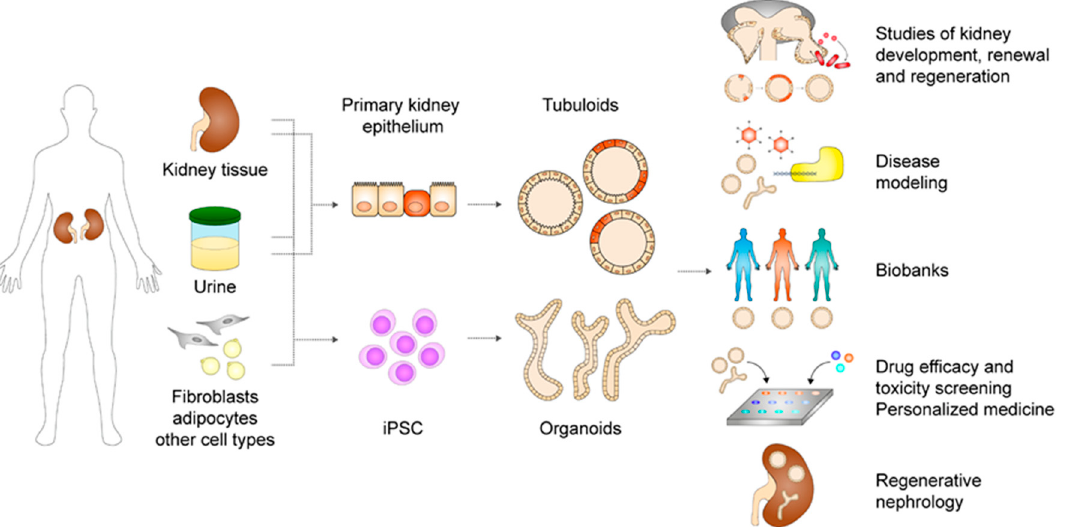
Figure 4. Establishment and applications of adult stem or progenitor cell-derived kidney tubuloids and induced pluripotent stem cell-derived kidney organoids. iPSC = induced pluripotent stem cell.